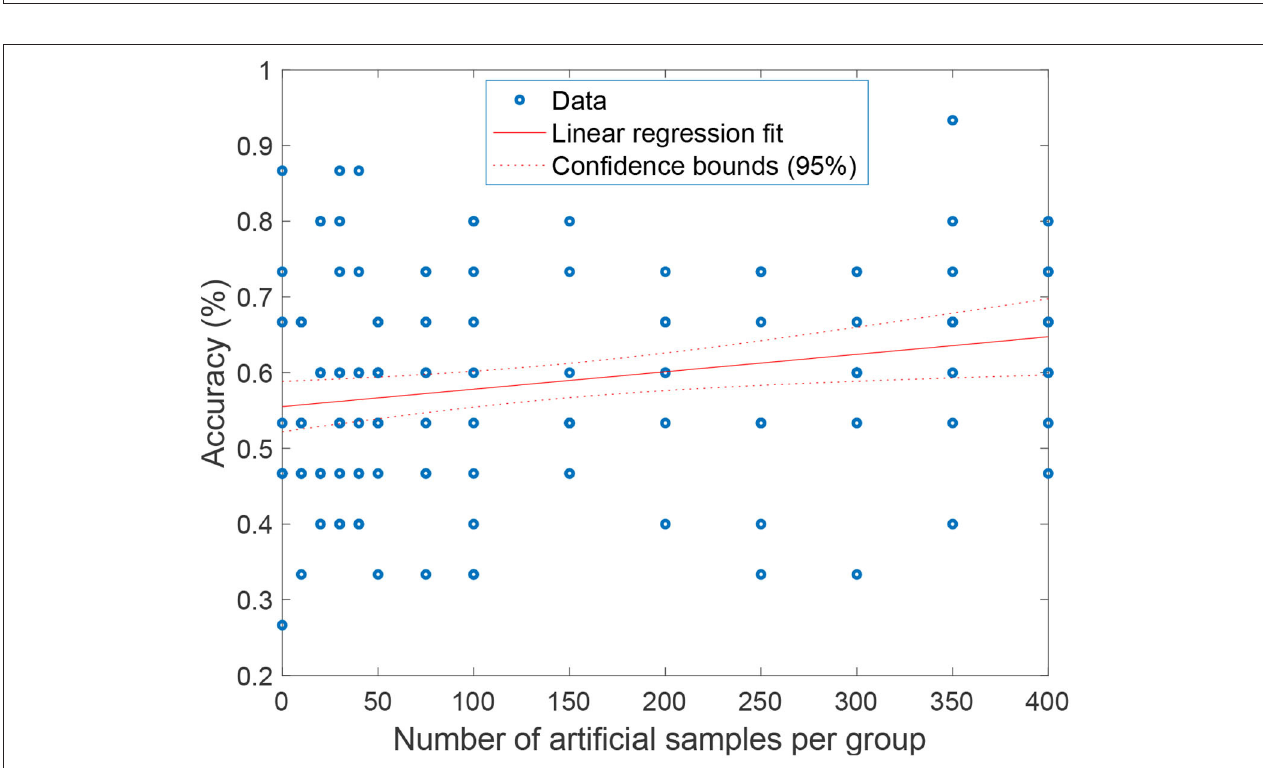
FIGURE 6 | The mean of accuracy and standard deviation with GEMD augmentation for the different number of artificial samples.